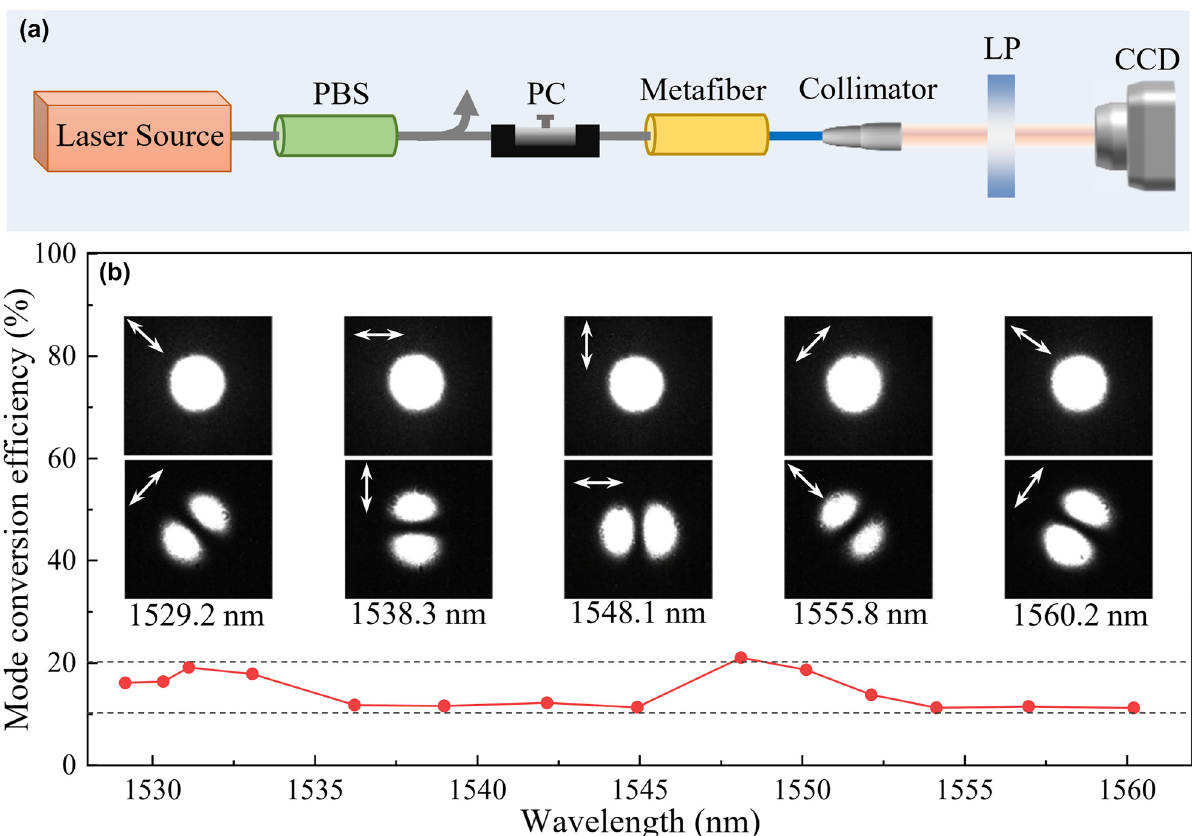
Figure 3: Measured mode conversion performances of the plasmonic metafiber. (a) Experimental setup for measurement. PBS, polarization beam splitter; PC, polarization controller; LP, linear polarizer; CCD, charge-coupled device. The gray and blue lines represent SMF and TMF, respectively. (b) Measured mode conversion performance and efficiency of the